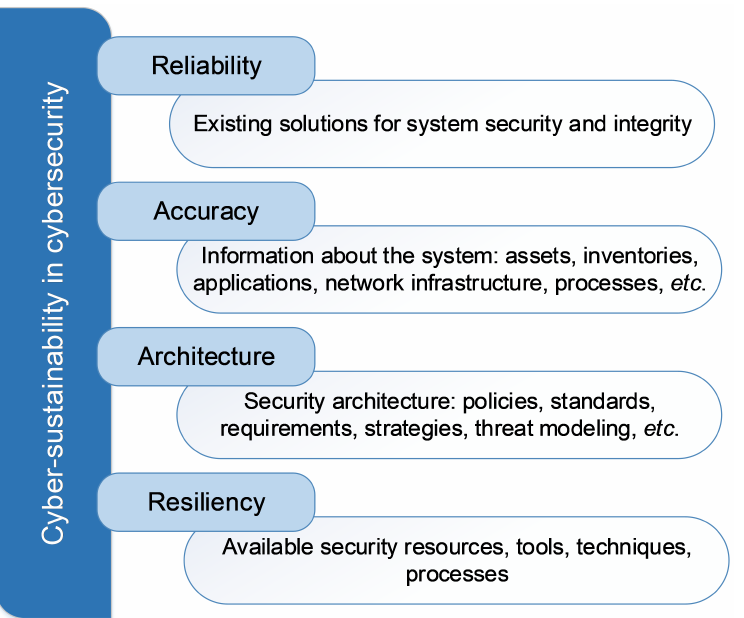
Figure 1. Management of cyber-sustainability in the context of cybersecurity (based on